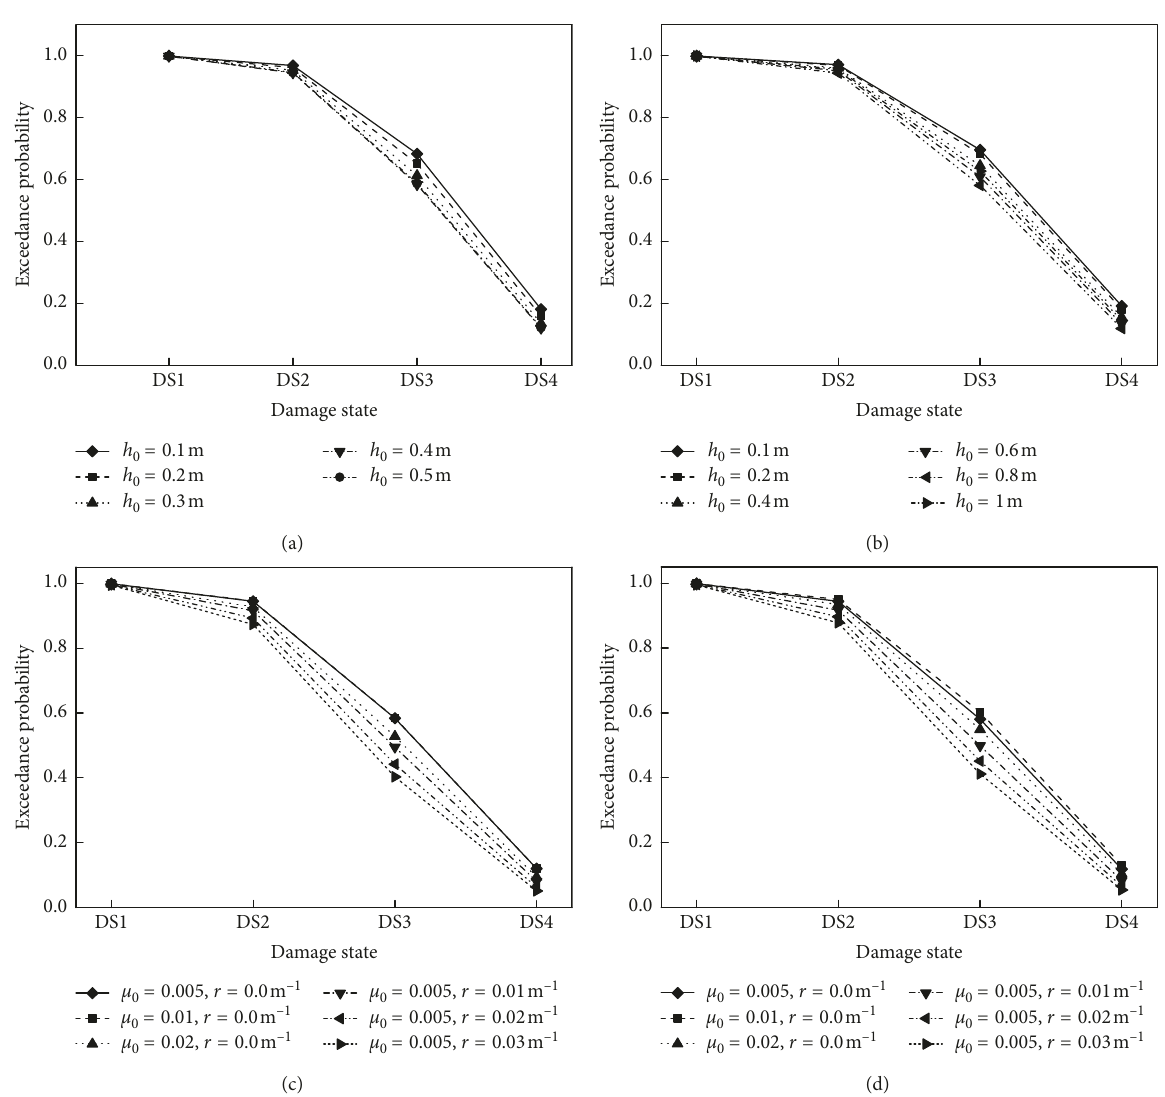
100kN/m, C 0kN s/m, and PGA 0.8g (the horizontal ordinate DS1, DS2, DS3, (cid:31) (cid:31) · (cid:31) 1 , h . 5m. (b) μ 0.005, r 0.0 m 1 (cid:31) 0 0 (cid:31) 0.005, r (cid:31) 0.0m (cid:31) (cid:31) . 0m, h . − 1 (cid:31) 1 0 (cid:31) 0